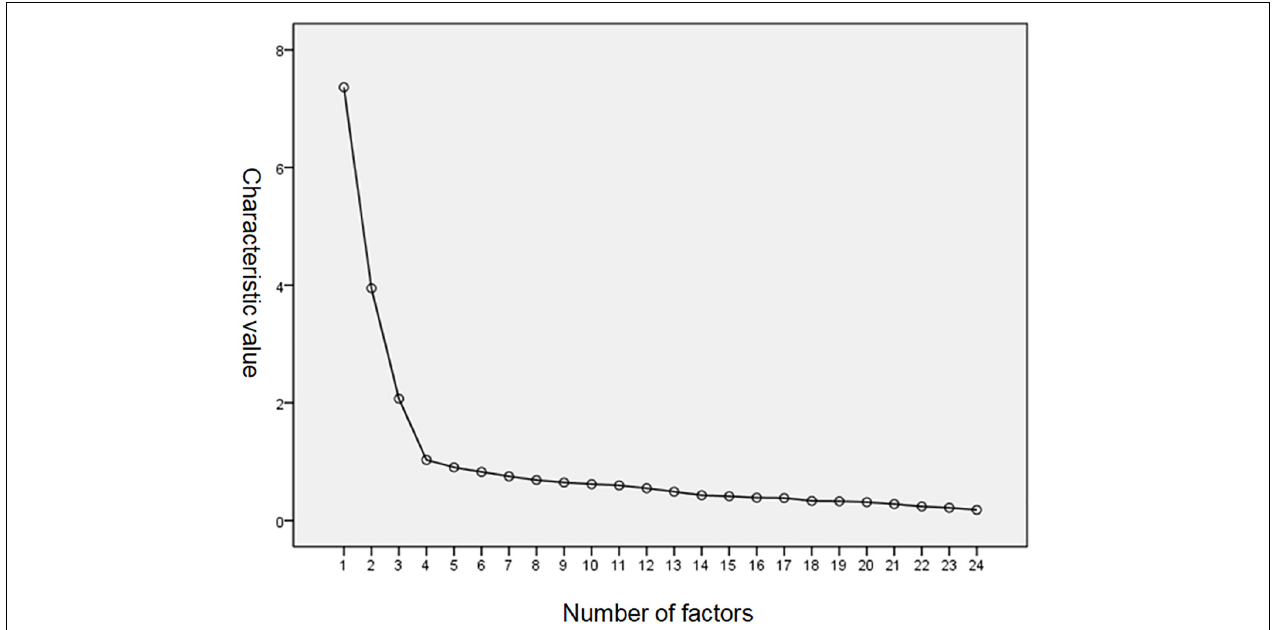
FIGURE 1 | The screen